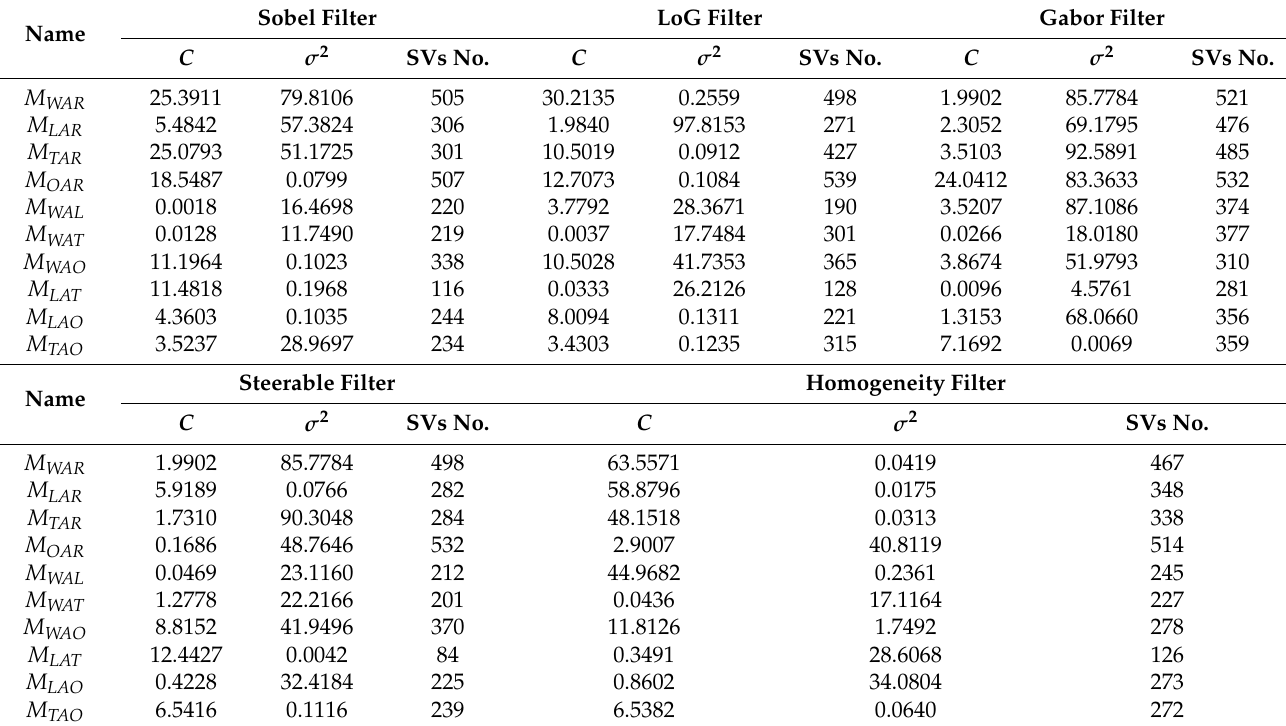
Figure 11. Example of SVM meta-parameter optimization: ( a ) Algorithm convergence; ( b ) meta-parameter evolution. Table 1. Training results of SVM sub-classifiers (SVs: support vectors).